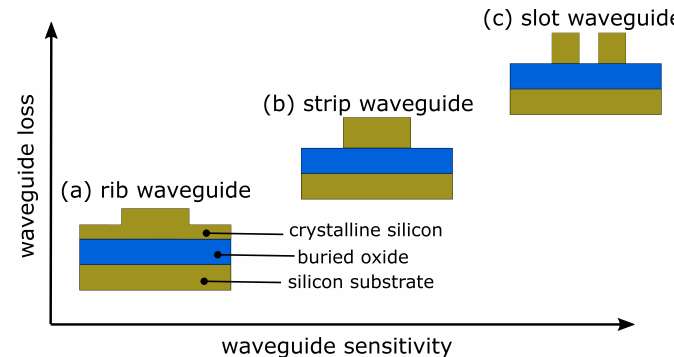
Figure 2. Typical silicon-on-insulator waveguide geometries for optical